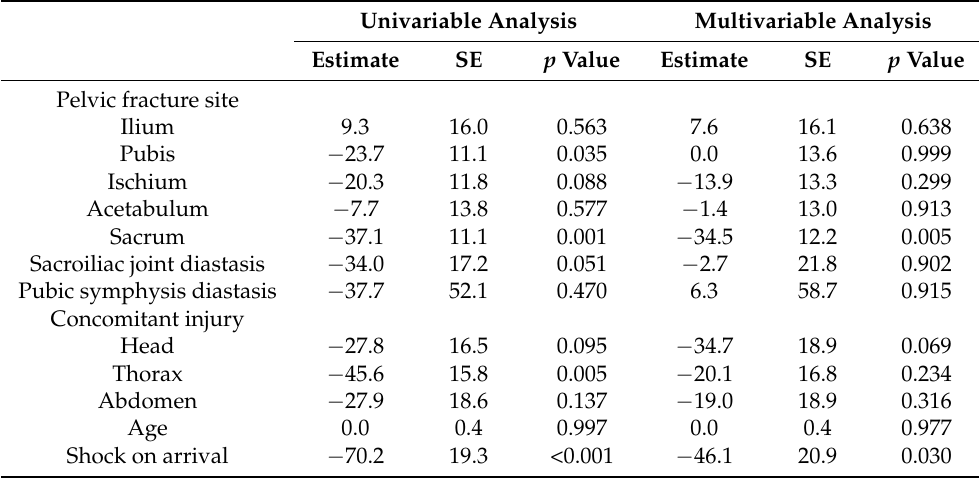
Table 3. Results of univariable and multivariable linear regression analyses assessing pelvic fracture site on minimum fibrinogen level within 24 h of arrival.